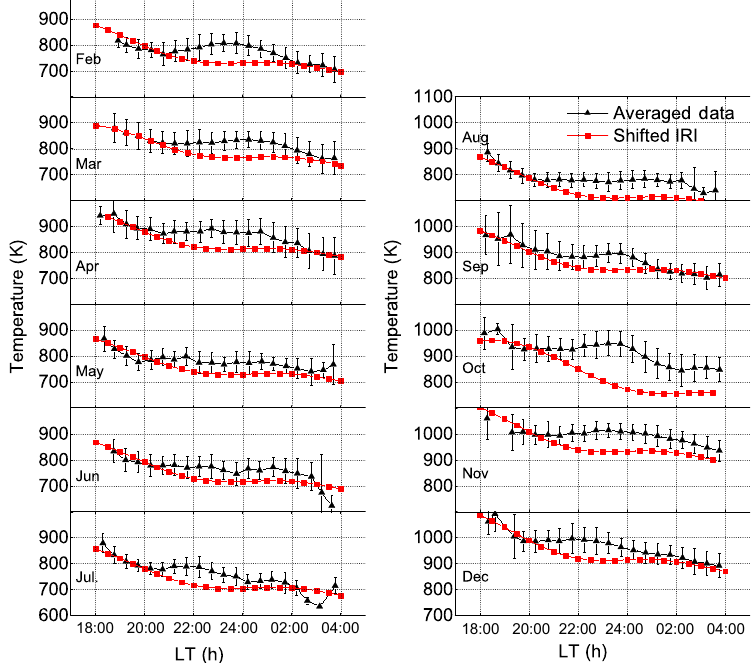
Figure 3. Monthly averaged temperature observed from February to December 2011 (black triangles). The averaged IRI curves, shifted to match the observed temperatures in the early evening (red squares).